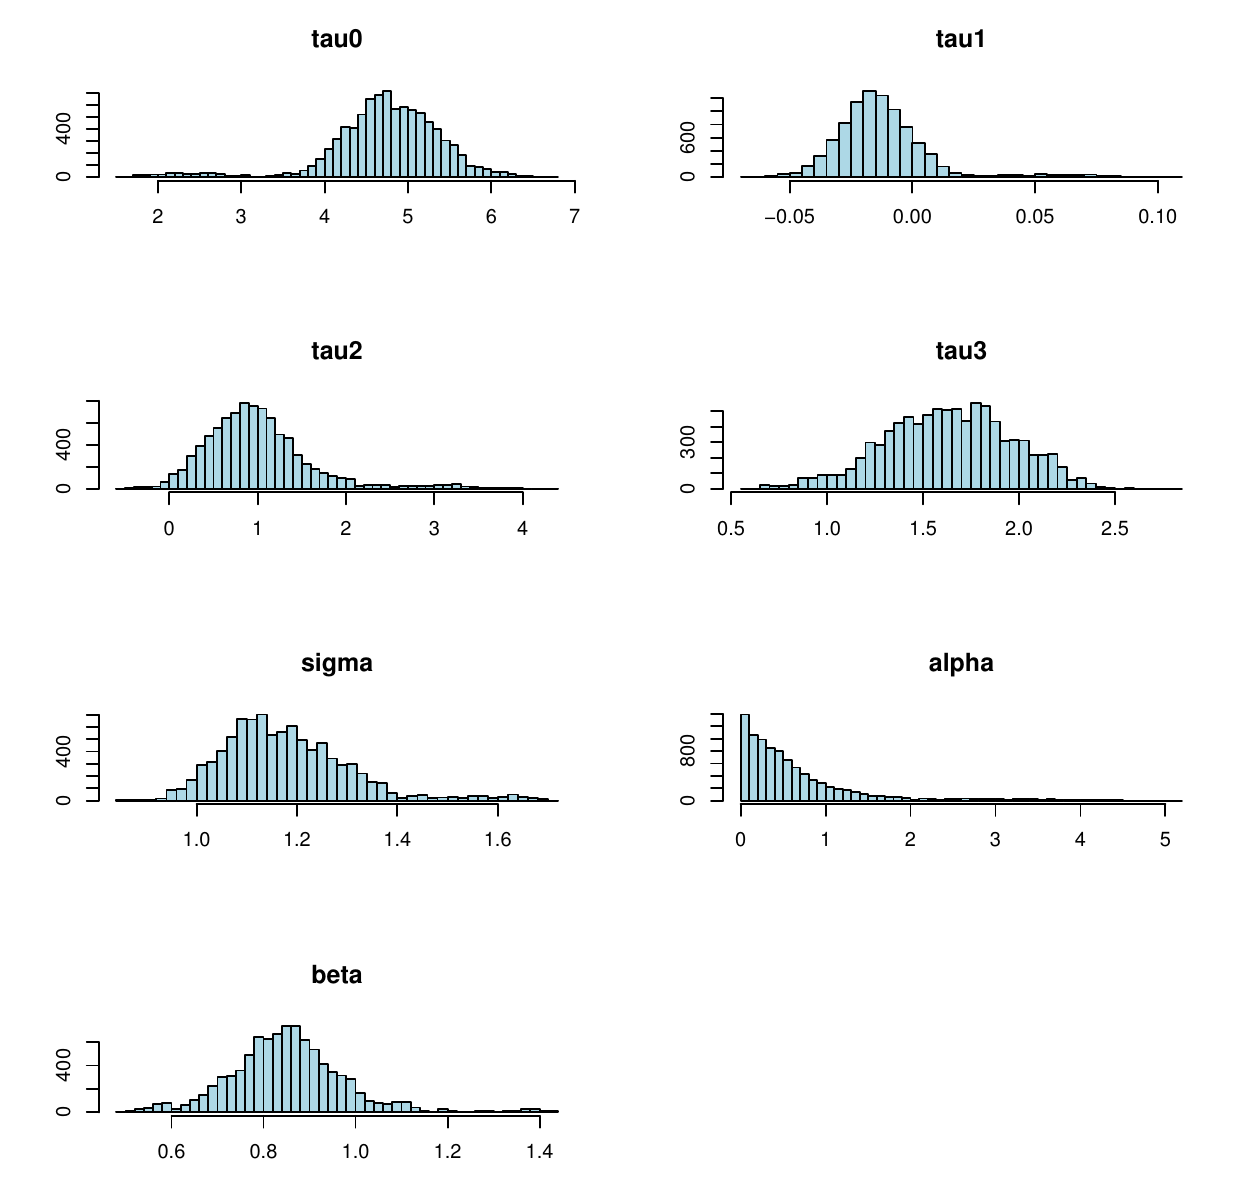
Figure 13. Histogram plots of Bayesian analysis and performance of Gibbs sampling for the each parameter of LATOLLW distribution based on the Heart transplant